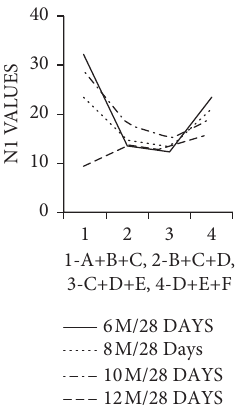
Figure 9: N1 values with increasing composition (28 days’ curing) combinations from A to F.